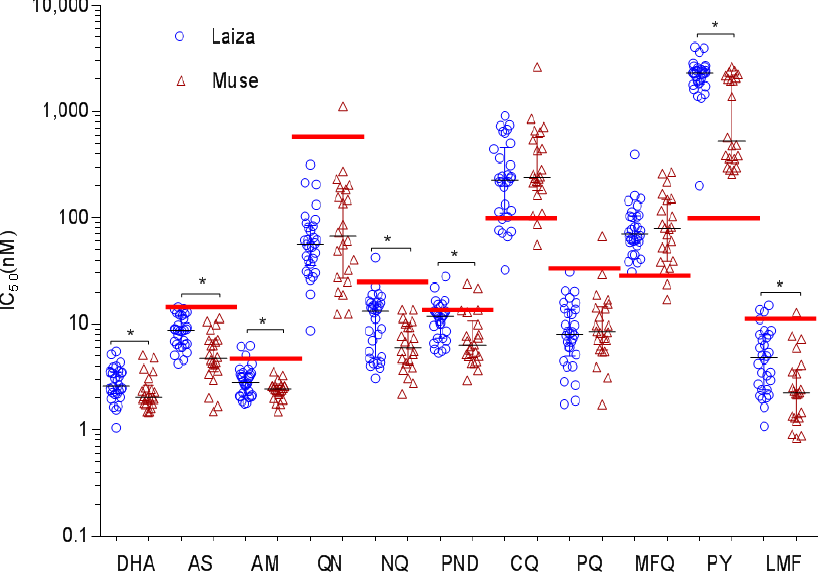
Figure 1. Dot plots of in vitro susceptibilities of parasite isolates from Laiza and Muse in eastern Myanmar to 11 antimalarial drugs. Asterisks indicate significant differences in drug sensitivity between the two regions ( p < 0.05, Mann–Whitney U test). Red bars indicate the cutoff values used to define resistance: CQ, 100 nM; QN, 600 nM; PY, 100 nM; MFQ, 30 nM; PQ, 31.2 nM; LMF, 11.8 nM; AS, 14.1 nM; AM, 4.7 nM; NQ, 23.8 nM; and PND, 15 nM. DHA, dihydroartemisinin; AS, artesunate; PPQ, piperaquine; MFQ, mefloquine; PY, pyrimethamine; LMF, lumefantrine.